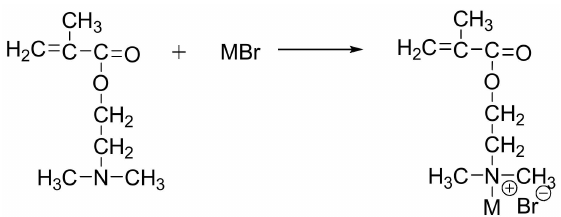
Figure 10. The synthetic route for preparation of hydrophobic monomer (M is n